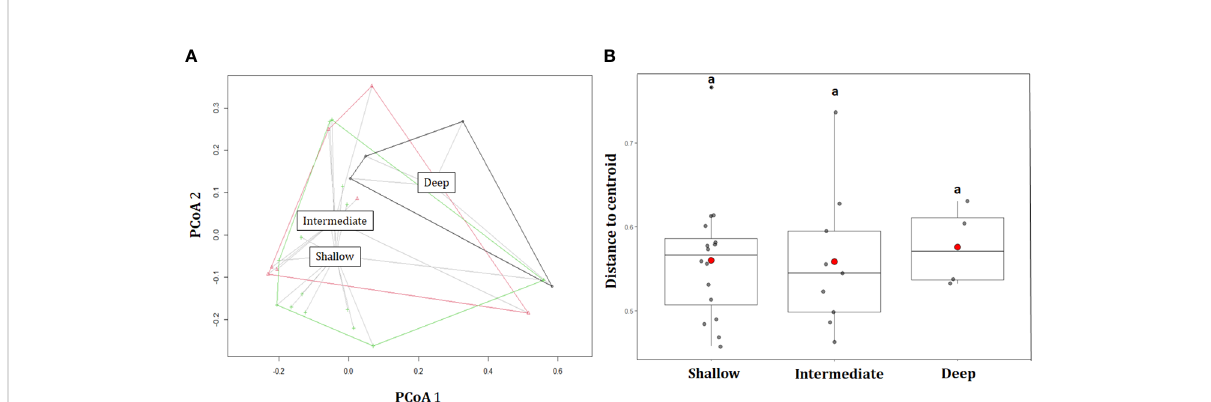
FIGURE 3 (A) Principal Coordinate Analysis (PCoA) and (B) boxplot of centroid distance for ROV stations (only “ hard bottom ” habitats) estimated for different bathymetric categories: shallow (0 – 60 m), intermediate (60 – 120 m), and deep (>120 m), as a measure of b -diversity. Mean values are represented by blue triangles. Same lowercase letters indicate not signi fi cant differences